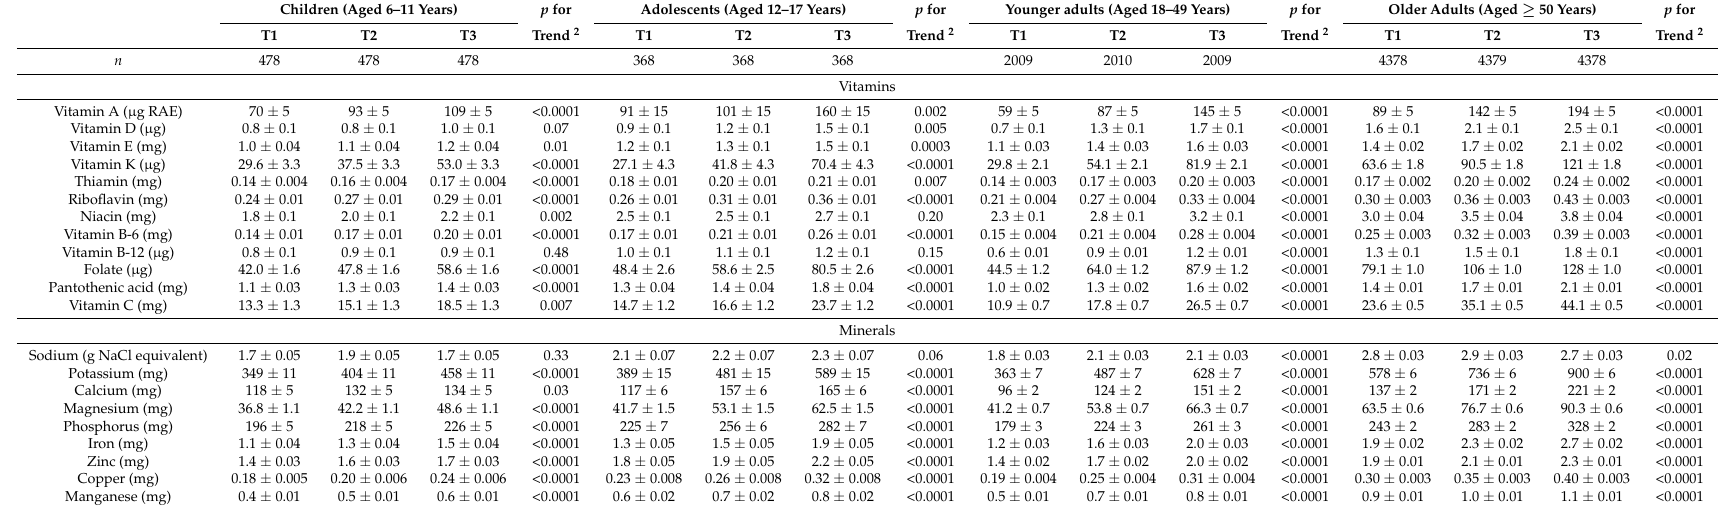
Table 3. Intakes of vitamins and minerals at breakfast among breakfast consumers according to tertile (T) category of the Nutrient-Rich Food Index 9.3 (NRF9.3) score as a measure of overall diet quality 1